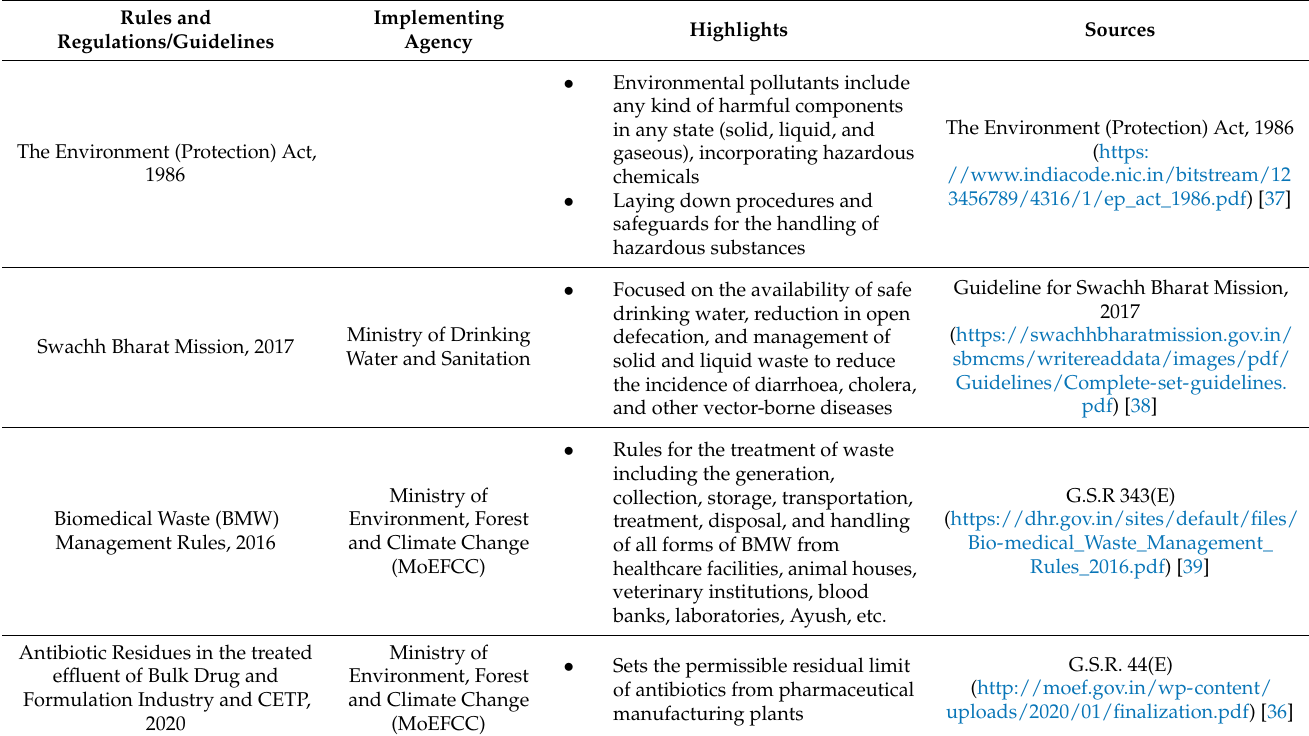
Table 4. Regulations and guidelines for the management of environmental pollutants to curb spread of AMR in the environment in